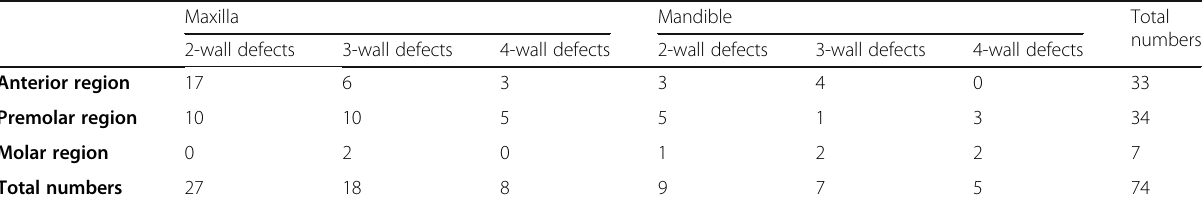
Table 1 Distribution of implants by location and type of defect